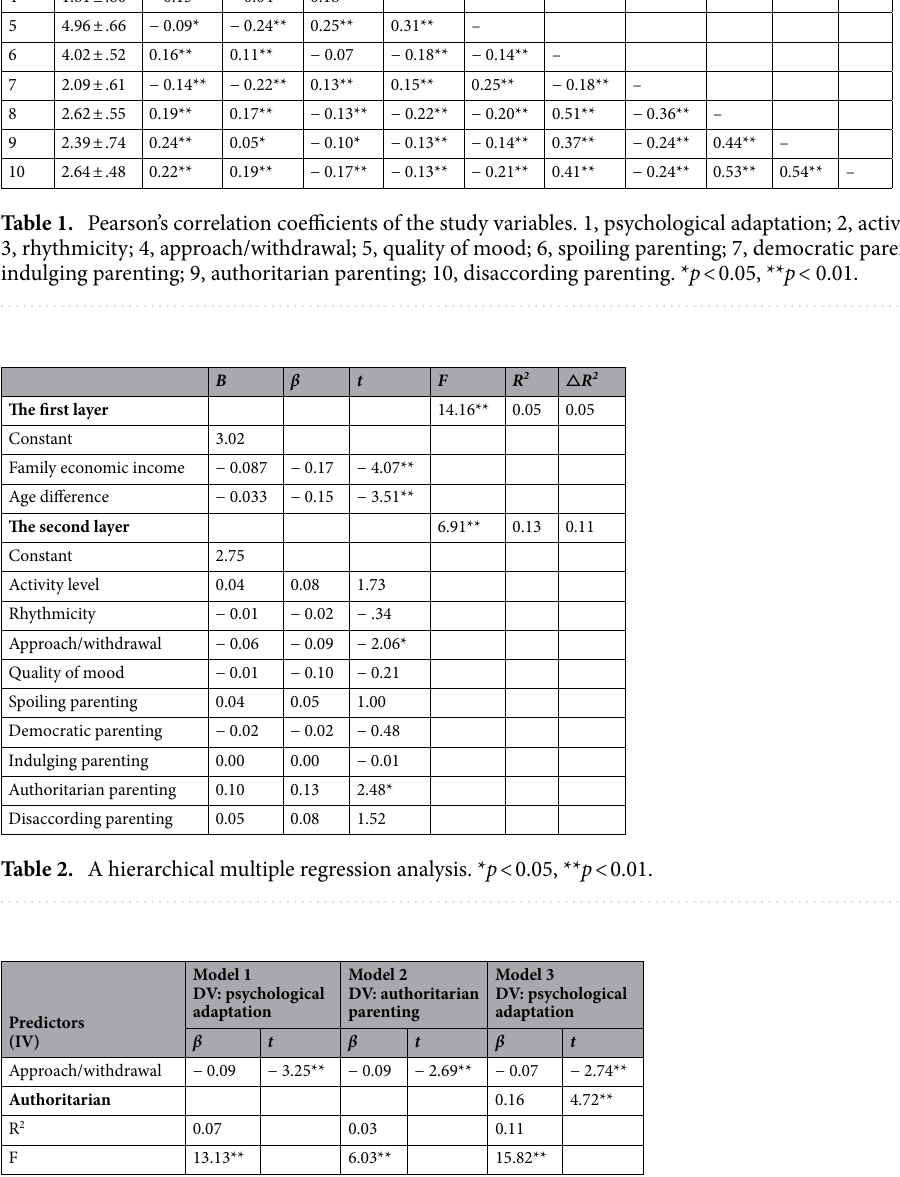
Table 3. Testing the mediation effect of authoritarian parenting. * p < 0.05, ** p < 0.01.